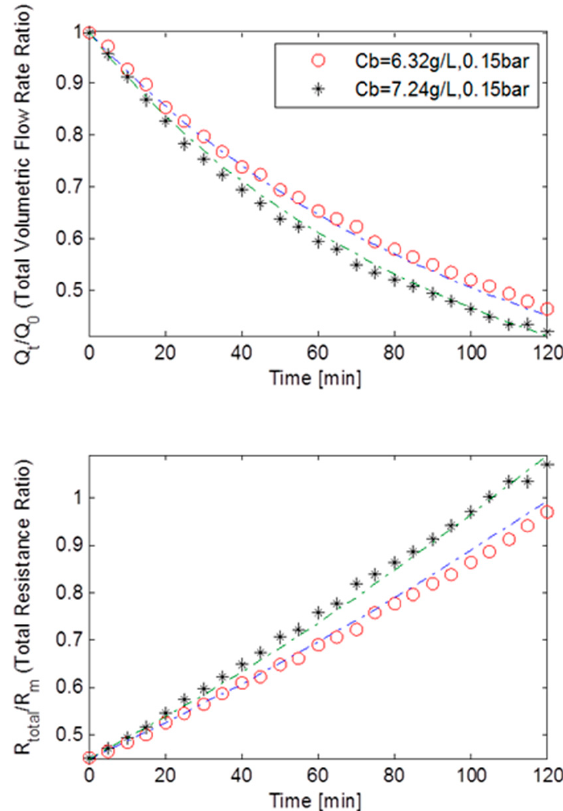
Figure 5. Flux decline and total resistance for TMP step of 15 kPa for the rotating MBR system RPU-185 with best model fits.